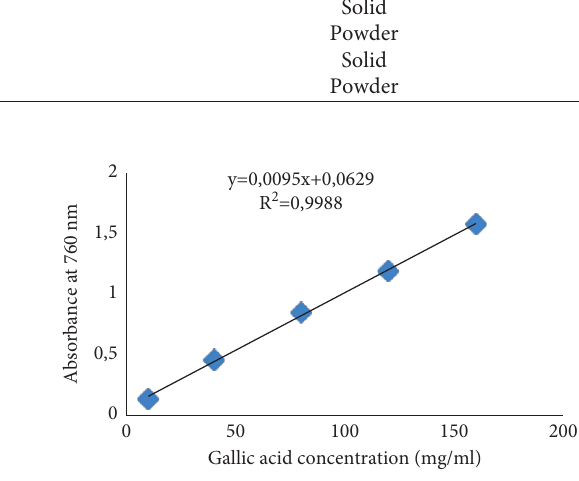
Figure 1: The curve calibration of gallic acid.